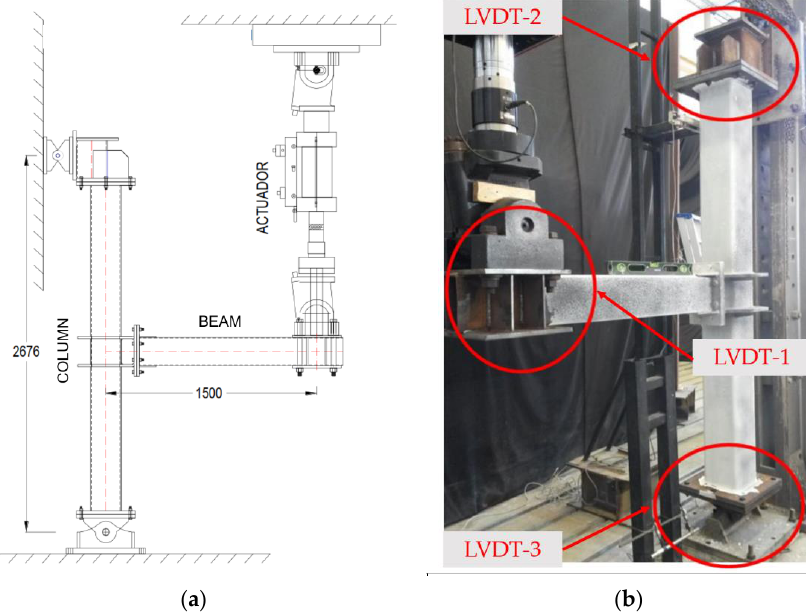
Figure 4. ( a ) Schematic view of test assembly, units in [mm] and ( b ) location of linear variable differential transformer (LVDT) in test assembly.